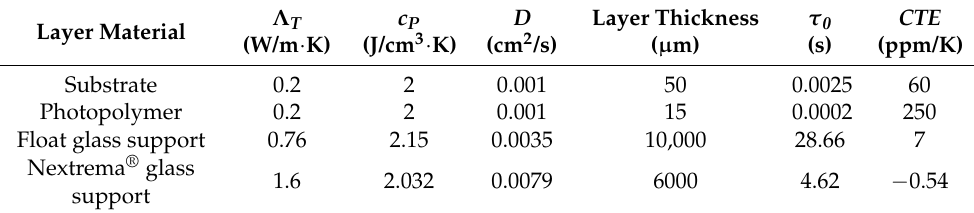
Table 1. Thermal material properties. Nextrema ® is a trademark of Schott Glas,